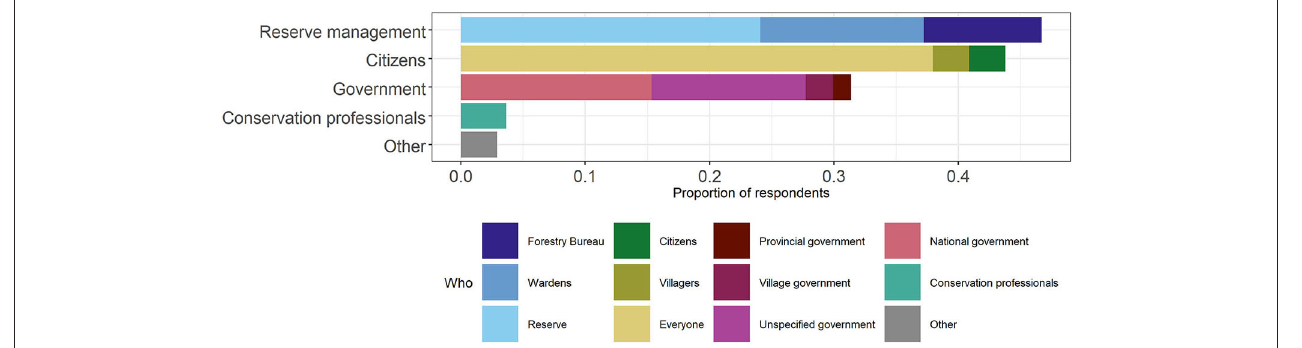
FIGURE 5 | Interviewee opinions on who they considered should be responsible for conservation ( n = 137).